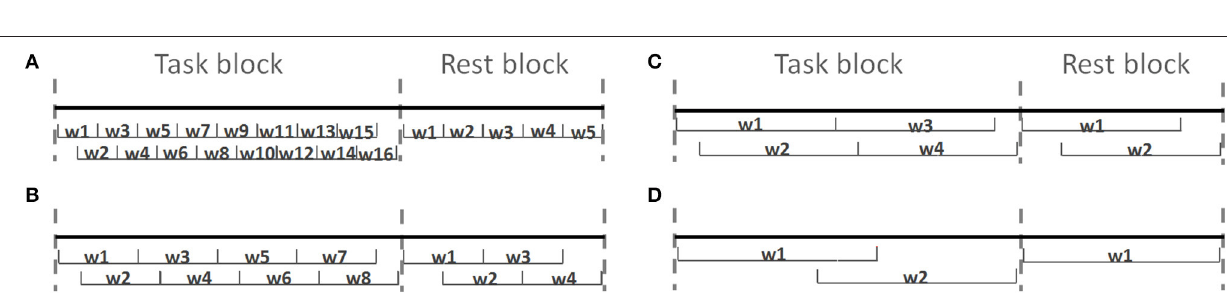
FIGURE 6 | Four different epoch styles based on length of windows. The task and rest blocks are divided into (A) 5, (B) 10, (C) 20, and (D) 25s windows (w i